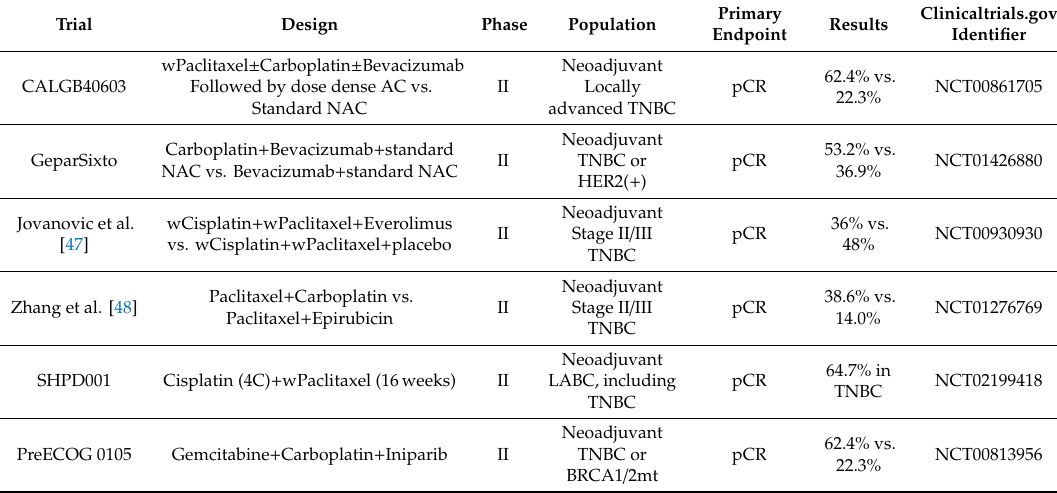
Table 1. Results of platinum agents in the NA clinical